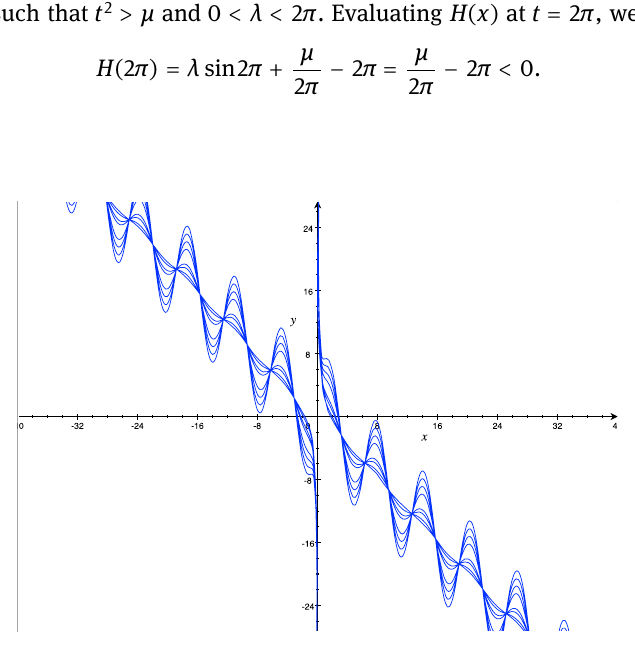
Figure 1: H x ( ) for λ 0.3, 0.7, 1.5, 2, 4, 5, 6, 7 = and μ 2.4 =